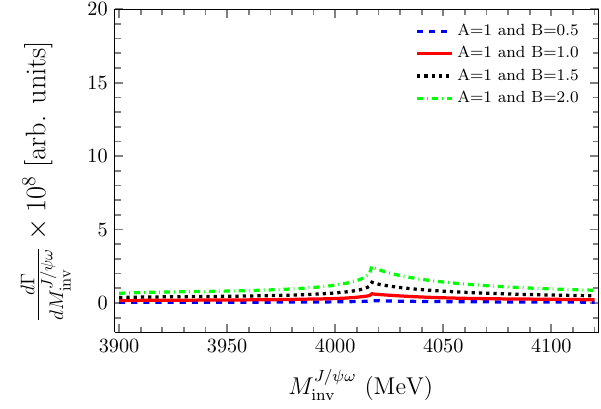
d (cid:8) results for the different values of the parameter B . The dM D ∗ ¯ D ∗ inv normalization is the same as in Fig. 5